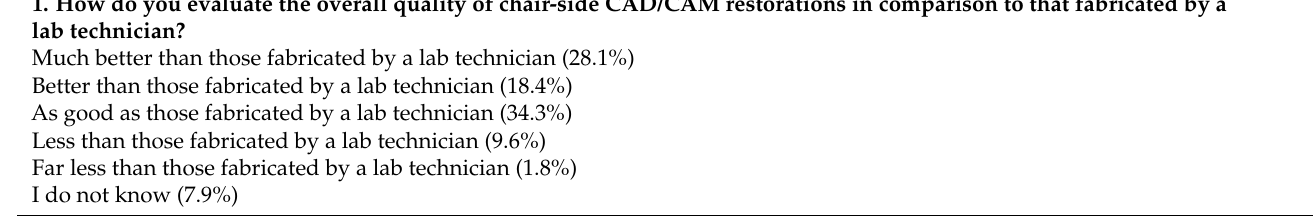
Table 3. Response of participating dentists to attitude-related questions (No. =